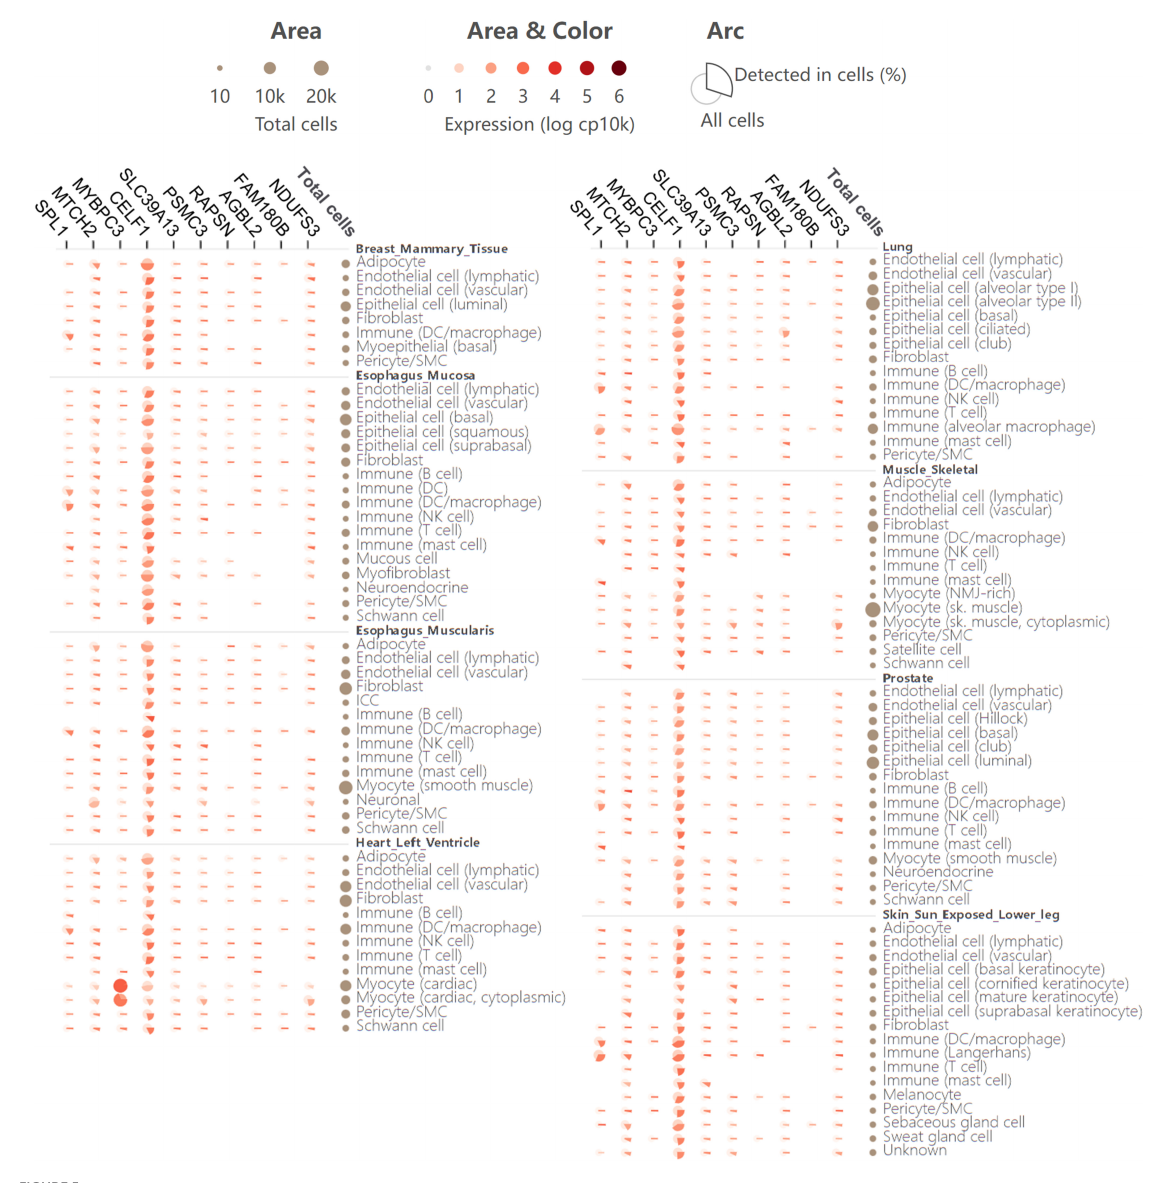
FIGURE5 Single-cell expression analysis of 11 pleiotropic genes shared by AD and glaucoma in various human cell types and tissues. Single-cell expression levels of 11 shared pleiotropic genes in provided human cell types and tissues. In the matric format displayed as an aster plot, each row indicates one cell type from its tissue and each column indicates one gene. The arc area and color represent the comparison of the expression of all cells versus cells in which the gene is detected. The arc length presents the fraction of cells in which a gene is